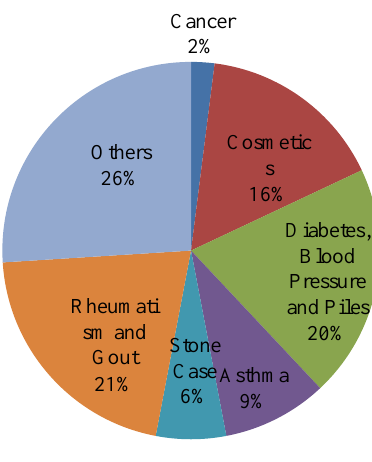
Figure 1. Percentage of plants used as cosmetics and as medicines for various illnesses [11] The dataset of surface temperature variation observed during 1954 - 2011 shows an increasing trend in both the minimum and maximum temperatures. The maximum